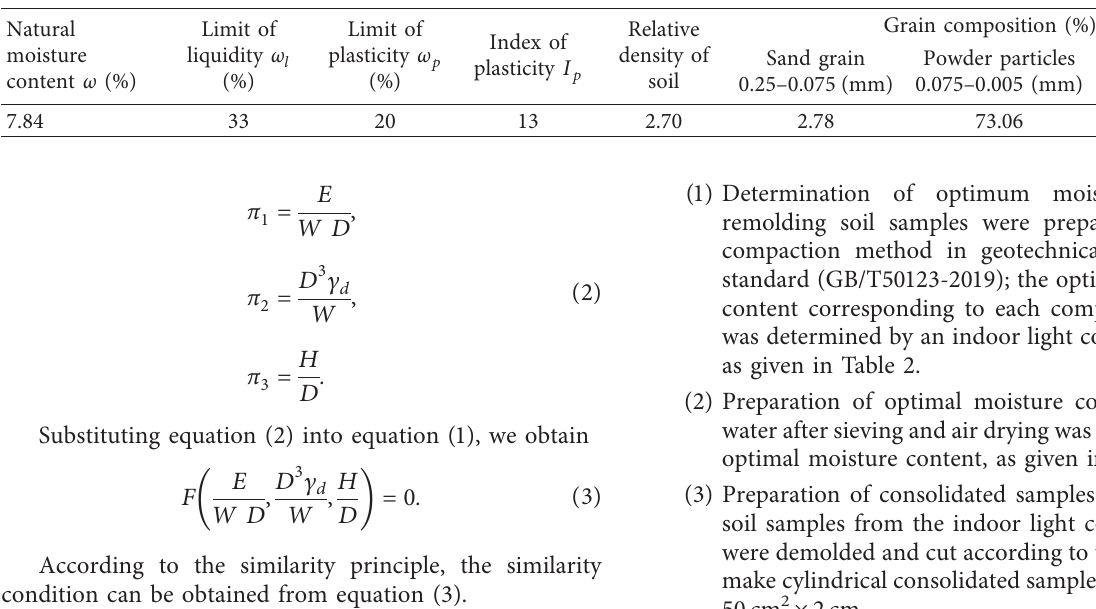
Table 1: Physical properties of the test